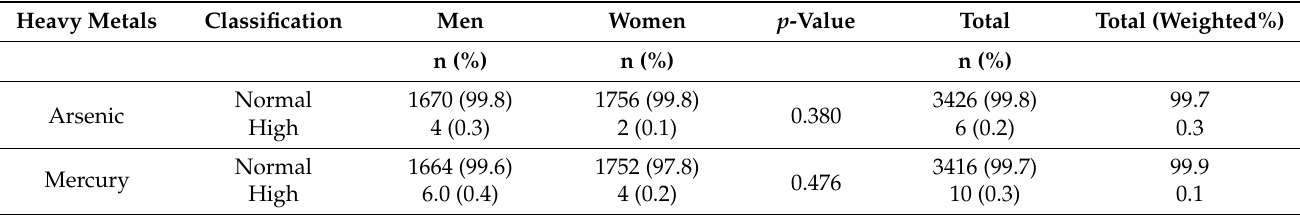
Table 4. Prevalence of arsenic and mercury levels among Saudi adults.